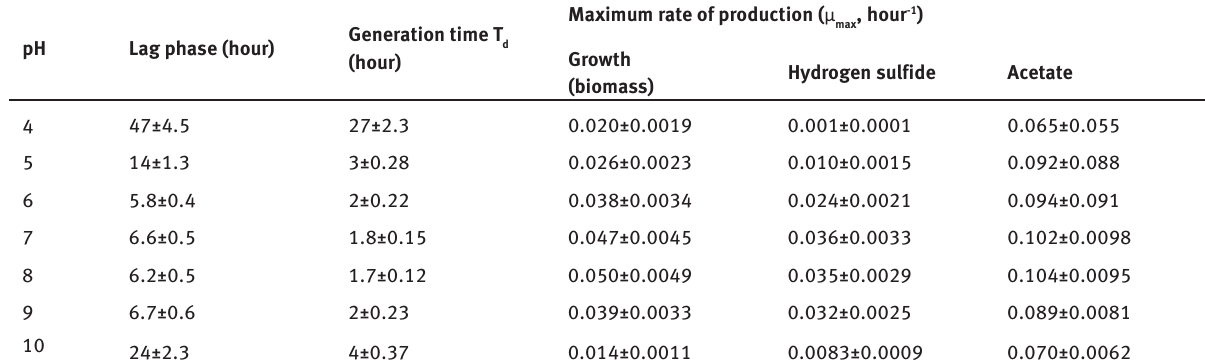
Table 1 : Kinetic parameters of D. piger Vib-7 growth under the effects of pH during 72 hours of